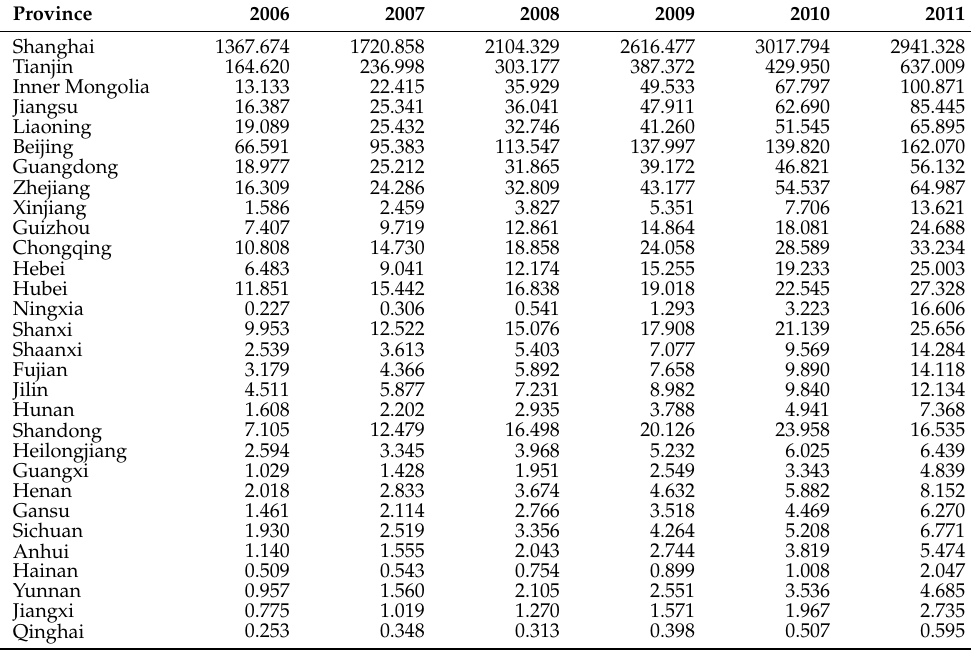
Table A8. The intra-provincial carbon inequality estimation results of original carbon emission data based on a 4-year rolling window for 30 provinces in China from 2006 to